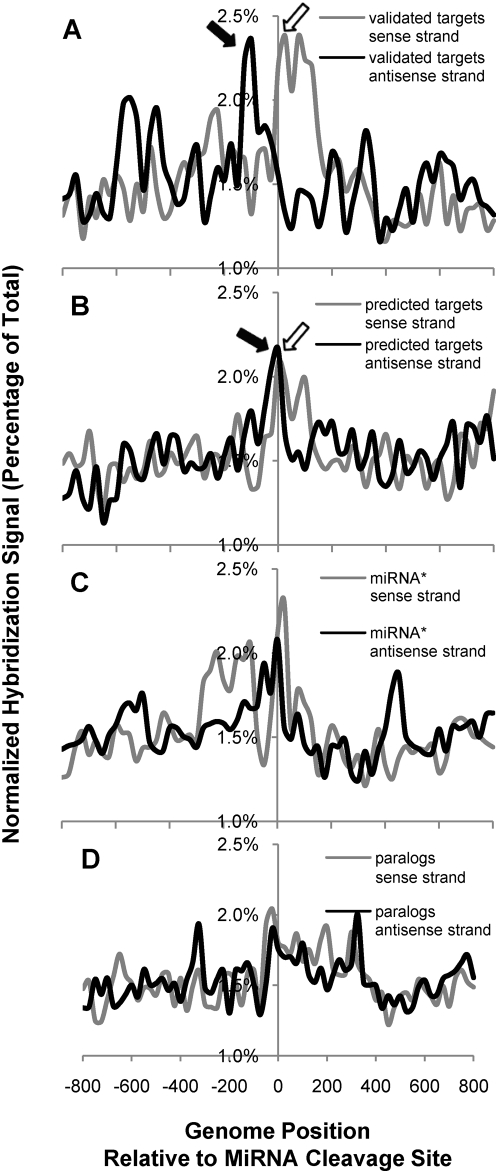
Average topology of sense and antisense transcript signals spanning miRNA target sites.(A) Validated miRNA targets (n = 78); (B) Predicted miRNA targets (n = 188); (C) miRNA genes (n = 159); (D) paralogous non-targets (n = 120). Data was collected from two published whole genome tiling microarray experiments with five samples from Arabidopsis flowers, leaves, roots, and two suspension cultures [11],[13]. For validated and predicted targets, each data point on the plot is the average of the normalized total signal from five tissue samples spanning 800 n.t. upstream and downstream of the validated or predicted miRNA cleavage sites. For MIRNA genes or paralogous non-targets, data for the same length of region spanning miRNA* sites or pseudo-binding sites was plotted. Signals on the sense strand are indicated by gray line and open arrow, while antisense signals are displayed by black line and black arrow. In panel A, antisense signals within the 200 n.t. range upstream (black arrow) and sense signals within the 200 n.t. range downstream (open arrow) of the miRNA cleavage site (coordinate 0 on x-axis) for validated targets have significantly higher signal intensity than elsewhere on the plot and than those in the same region of paralogs (95% confidence interval, see Tables S3 and S4). In panel B, antisense signals within the 200 n.t. range upstream of the predicted miRNA cleavage site (black arrow) is also statistically higher than those in the same region of paralogs.